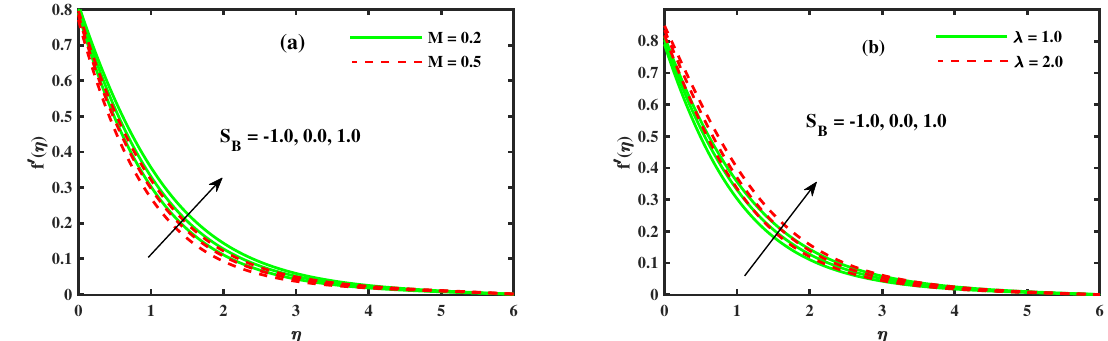
Figure 3. The impact of f (cid:48) ( η ) for ( a ) Magnetic M and ( b ) thermal buoyancy λ .